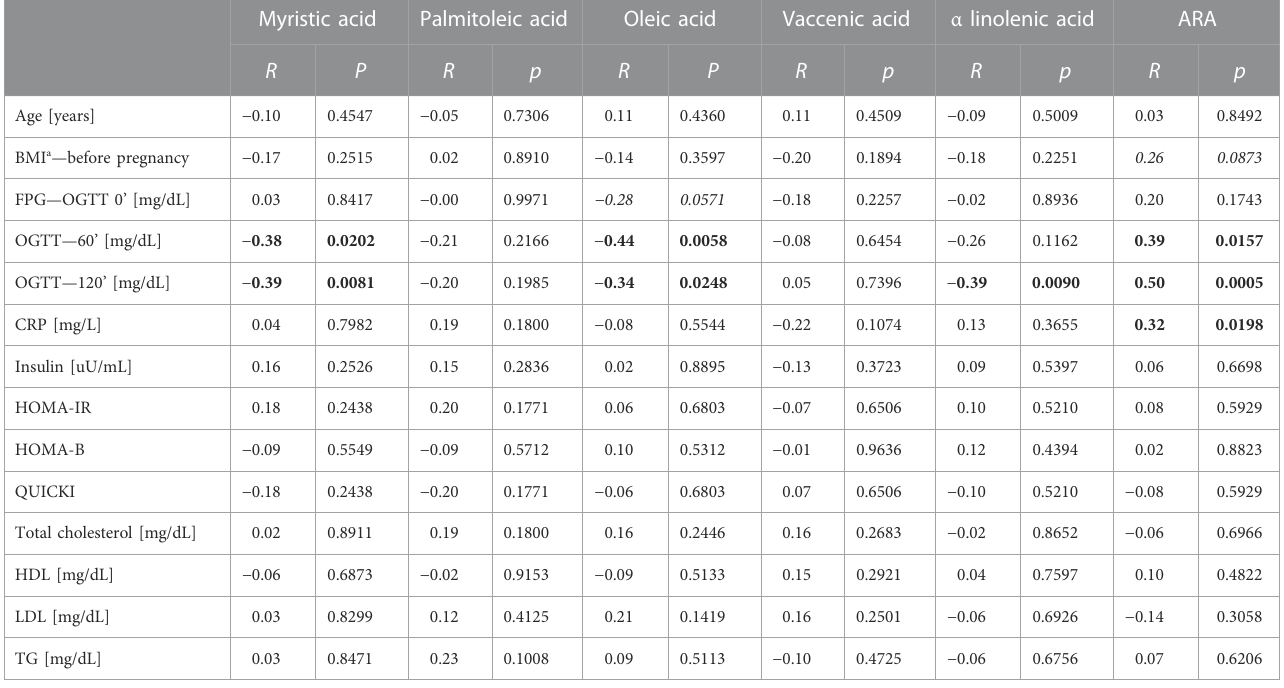
TABLE 4 Correlation with clinical data with top six changed cholesteryl esters — GDM and NGT together in the group.